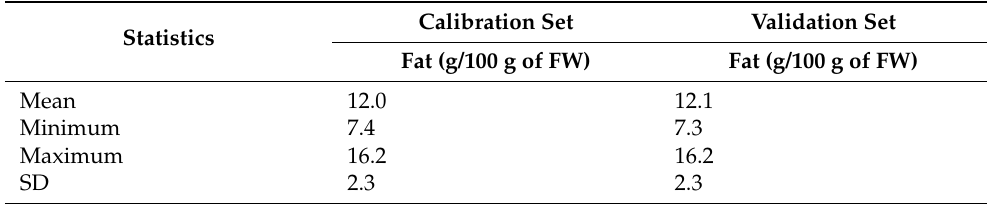
Table 4. Fat content on a fresh weight (FW) basis (g/100 g) of the living Tenebrio molitor larvae in the calibration ( n = 80) and validation ( n = 40)